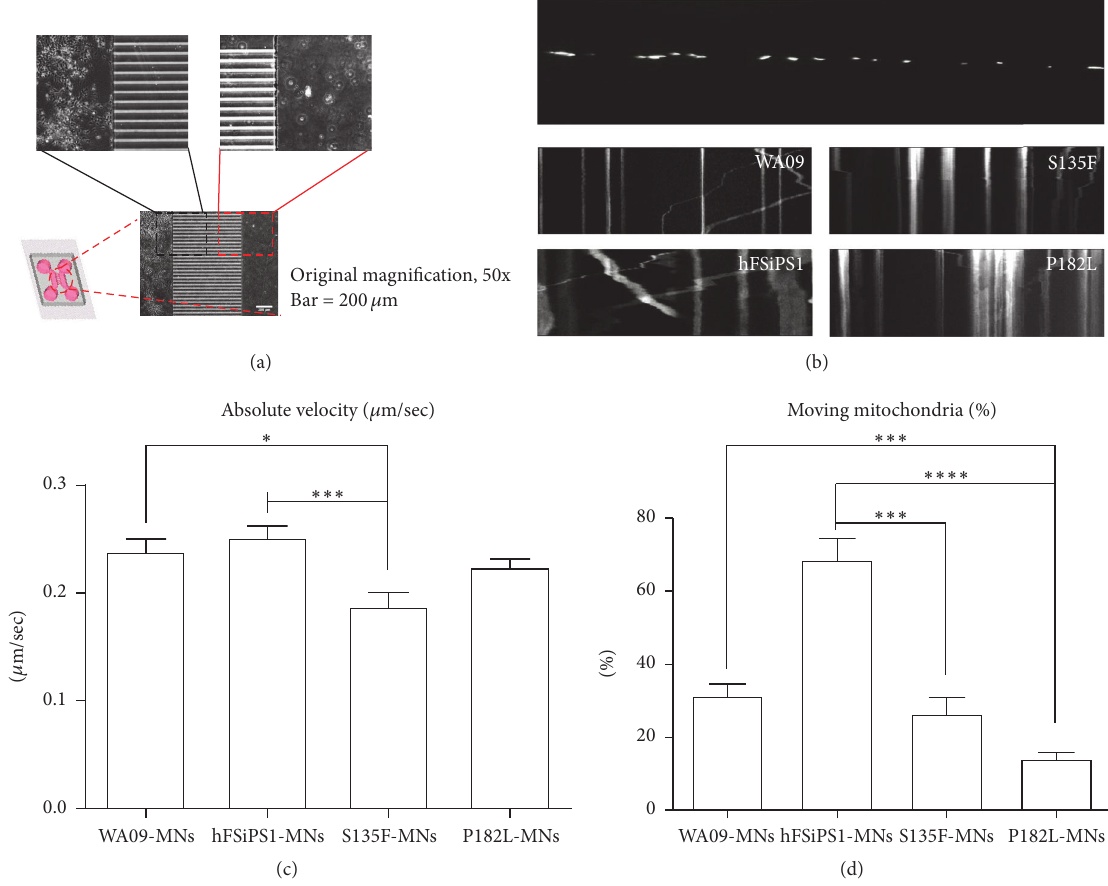
Figure 3: Axonal transport of mitochondria in control MNs, S135F-MNs and P182L-MNs. (a) Microfluidic culturing system. Microchannel plates were made from transparent polymer in a specialized mold to create multicompartments connected by 𝜇 m-sized grooves (833.4 𝜇 m long in length) that only allow growing axons to pass through, thereby separating the microenvironments of neuronal components. (b) Visualization of mitochondria by Mito-dsRED2 transfection (upper image) and kymograph images for mitochondria movement (middle and lower four images). Mito-dsRED2 vector was introduced into fully differentiated MNs cultured on microchannel plates for an additional 1 week. Mitochondrial images were taken at a ratio of 121 snaps/2min and stacked into kymograph for analysis (original magnification, 1000x). (c) S135F-MNs show decreased velocity of moving mitochondria compared to control MNs. Unpaired t -tests, ∗ 𝑃 < 0.05 , ∗∗∗ 𝑃 < 0.001 , and ∗∗∗∗ 𝑃 < 0.0001 . Absolute velocity of moving mitochondria was calculated from measured angle and length in kymograph images using ImageJ (WA09-MNs; 𝑁 = 203 , hFSiPS1-MNs; 𝑁 = 512 , S135F-MNs; 𝑁 = 428 , and P182L-MNs; 𝑁 = 496 ). (d) S135F-MNs and P182L- MNs show reduced moving proportion of mitochondria in an axon (WA09-MNs; 𝑁 = 9 , hFSiPS1-MNs; 𝑁 = 6 , S135F-MNs; 𝑁 = 20 , and P182L-MNs; 𝑁 = 42